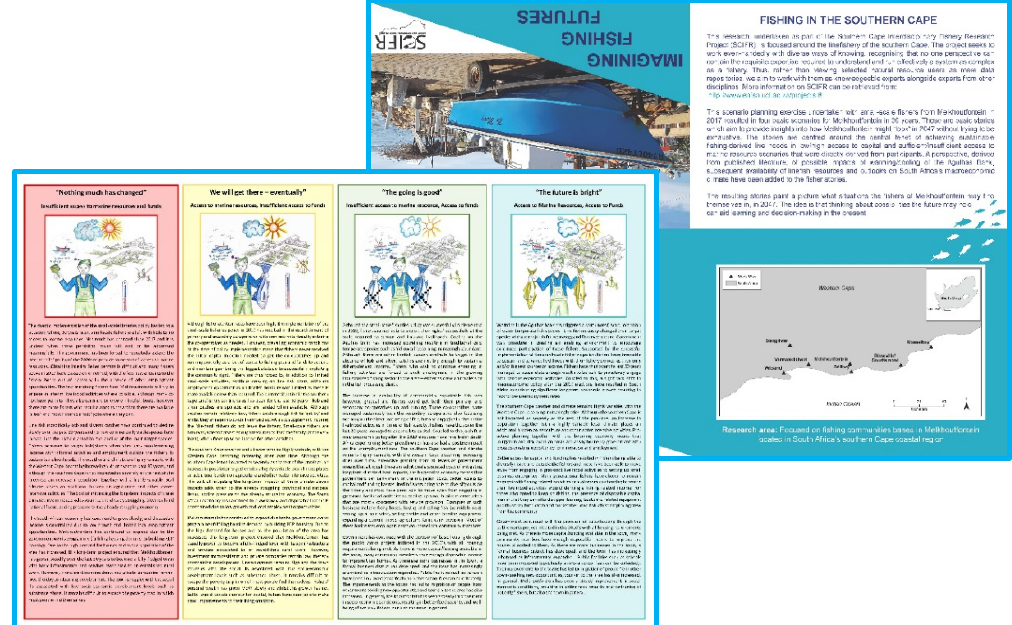
Figure A4.1. The pamphlet was produced for feedback to the fishers (presented folded twice over, i.e. A6 format). The pamphlet was made available both in English and Afrikaans (from Gammage, 2019).